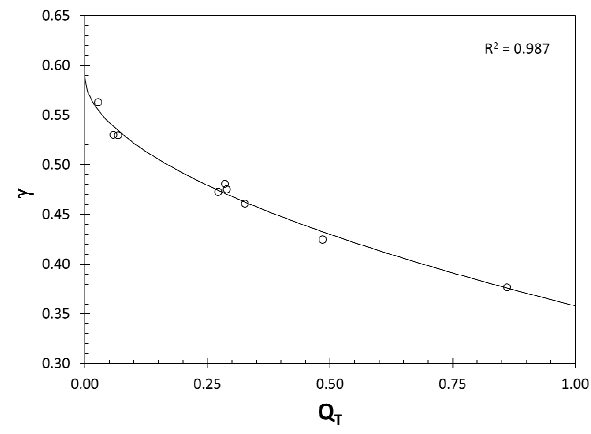
Figure 2. The change in γ as a function of Q T .